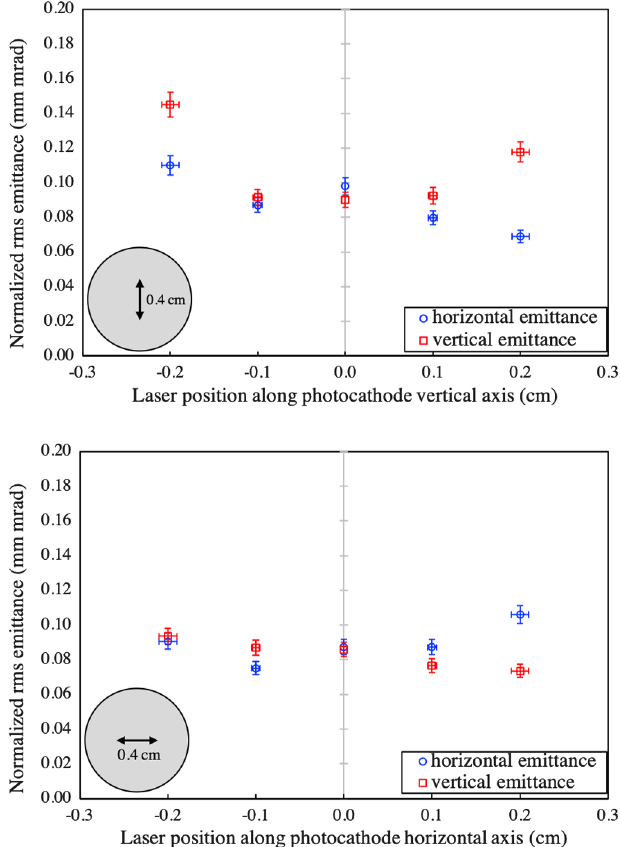
FIG. 9. Normalized rms emittance measured for a set of laser positions along the vertical axis (top) and horizontal (bottom) axis of the photocathode. The laser spot size at the photocathode was 0.2 mm rms and the photogun voltage − 200 kV. The inset in each graph depicts the size and orientation of the laser scan with respect to the